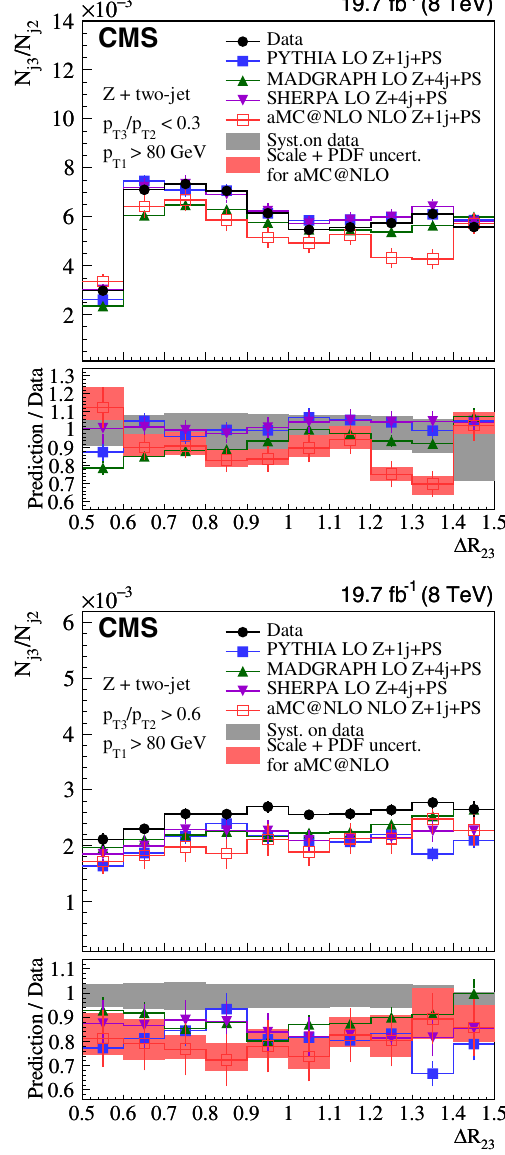
√ s = 8TeV compared to theory: (upper) / p < 0 . 3), (lower) Δ R T2 23 for hard radi-